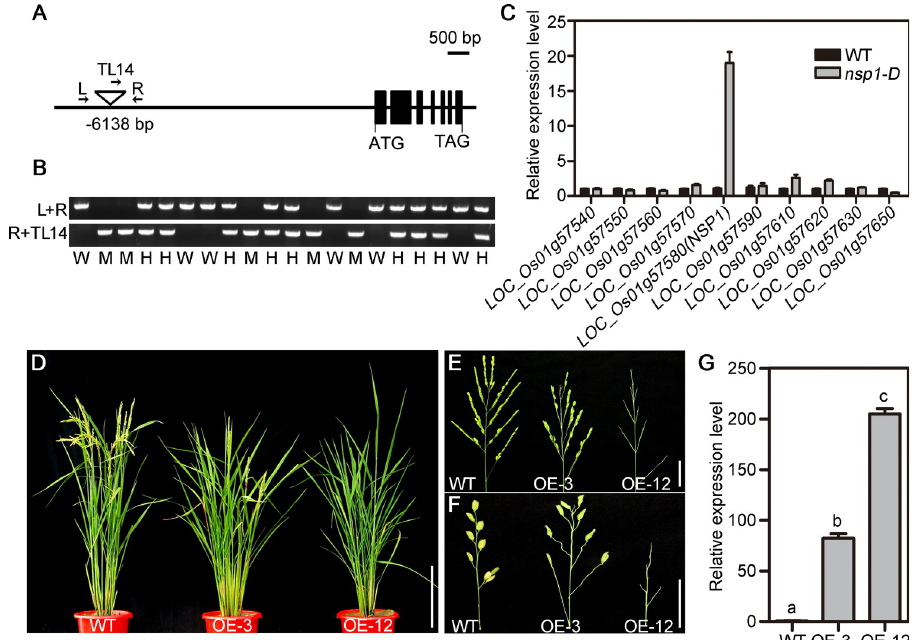
Fig 3. Identification of No Spikelet 1 ( NSP1 ). (A) Structure of the NSP1 genome and the T-DNA insertion site. Black boxes represent exons; lines between the boxes represent introns; the inverted triangle indicates T-DNA. Primers L and R on the NSP1 genome and primer TL14 at the T-DNA left border used for genotype analysis are marked with arrows. (B) Co-segregation analysis of nsp1-D/+ . W, H, and M indicate wild type (WT), heterozygous, and homozygous for T-DNA insertion, respectively. (C) Quantitative RT-PCR analysis of genes flanking the T-DNA insertion site in young panicles ( < 5 mm) of WT and nsp1-D . The internal rice Ubiquitin ( UBQ ) gene was used to normalize gene expression. Data are the means ± SEM from nine replicates. (D) to (F) Plant morphology (D) and panicle morphology (E) of 35S-pOsbHLH069 :: OsbHLH069 transgenic plants (OE-3 and OE-12). (F) Closeup view of one primary branch in (E). (G) Expression analysis of OsbHLH069 in the leaves of the 35S-pOsbHLH069 :: OsbHLH069 transgenic plants (OE-3 and OE-12). Gene expression was normalized to the rice UBQ gene. Values shown indicate the means ± SEM from three replicates. Different letters denote significant differences ranked by the Dunnett’s test (one- way analysis of variance, P < 0.05). Bars = 20 cm in (D) and 4 cm in (E,